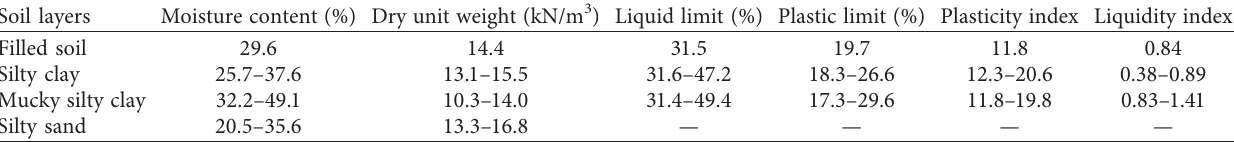
Table 2: Geotechnical parameters for different soil layers.